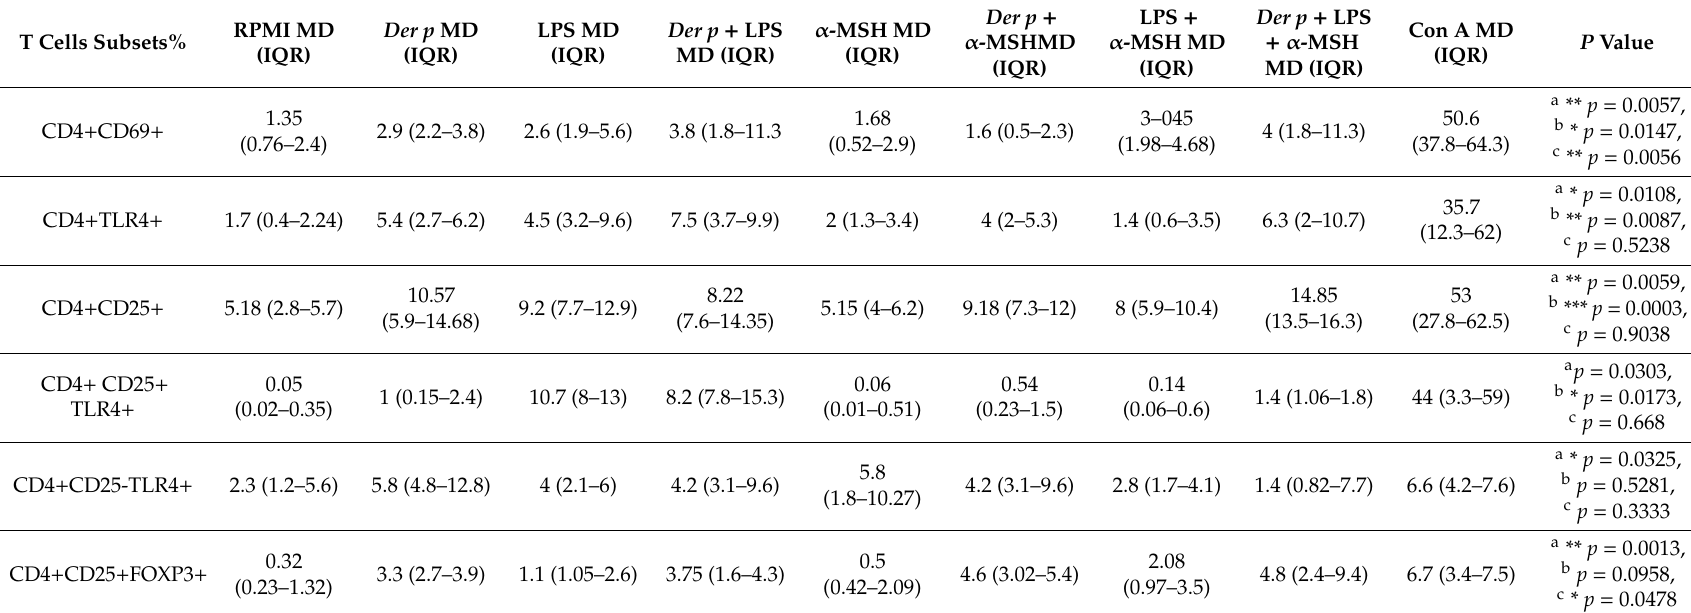
Table 4. CD4 + T cell populations after 72 h of culturing with Der p , LPS, and α